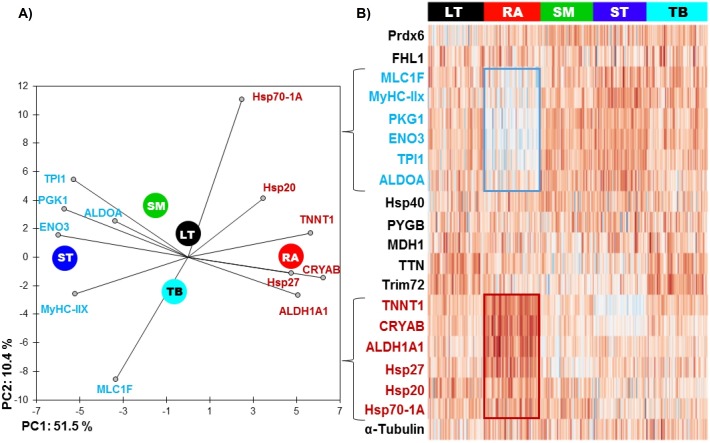
(A) Principal component analysis (PCA) of the most discriminating proteins between the muscles using the RA muscle as a reference and (B) unsupervised hierarchical clustering heatmap highlighting the proteins, which are low (blue) and high (red) abundant.The graph is showing the differences in the relative abundances of the proteins studied namely between RA and ST muscle. Colors correspond to the log2 transformed values of protein fold-change.